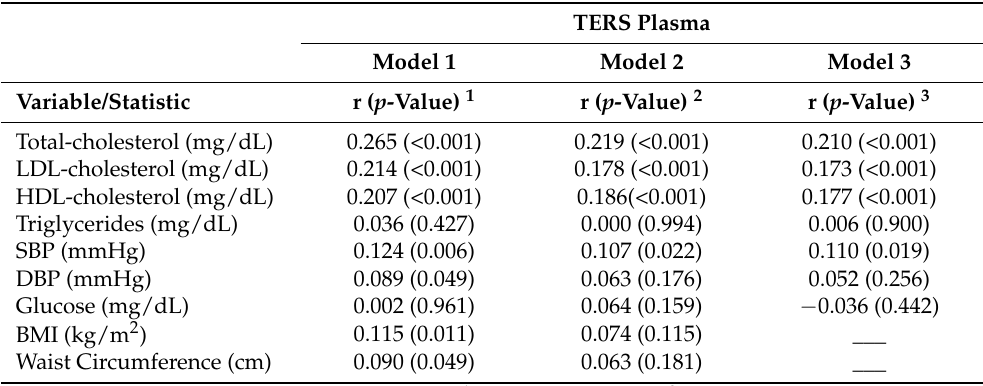
Table 6. Combined association between plasma levels of trace elements (Zn, Cu, Se, and Mn) and cardiovascular risk factors (as continuous). Trace elements risk score (TERS)